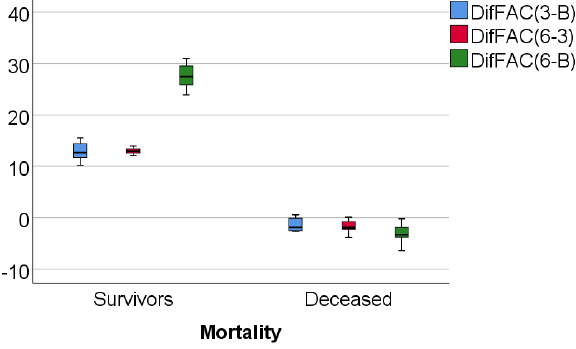
Figure 4. Box-plot representation of RVFWLS evolution in comparison with mortality.